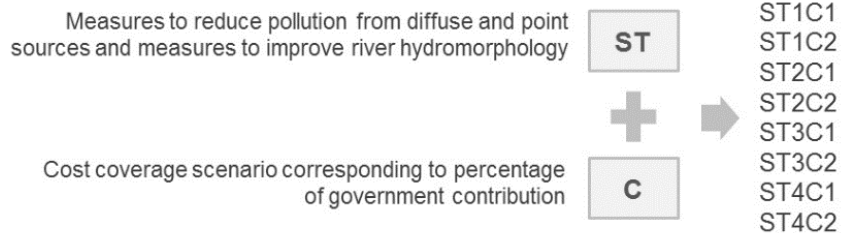
Figure 2. Summary of the proposed decision alternatives for the Integrated River Basin Management for the Werra River (IRBM-W) combining four emission strategies with two cost coverage scenarios.